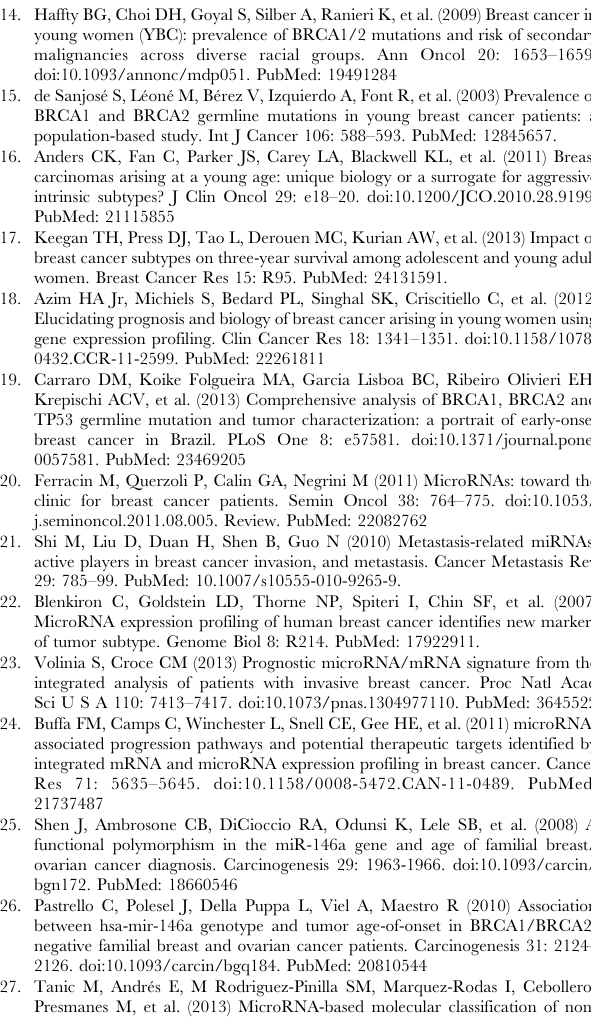
Table S1 Microarray raw data from GEO accession number GSE37126 showing the correspondent samples ID of the present study. Table S2 Target-genes selected to validation. Table S3 91 differently expressed candidate genes. List of 91 differentially expressed genes associated to at least one miR. Table S4 49 miRNA–mRNA interactions. Interactions presenting significant differences of co-expression profile between F-BC and NF-BC.